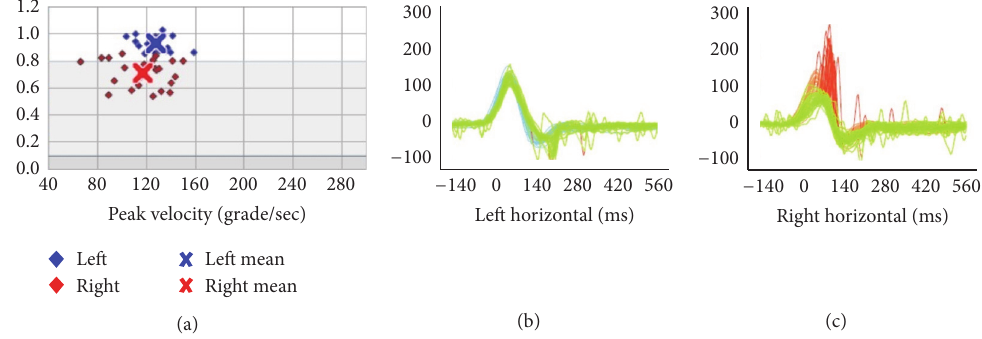
Figure 2: Horizontal passive vHIT after unilateral training: left gain: 0.93 ± 0.05; right gain: 0.71 ± 0.10; asymmetry: